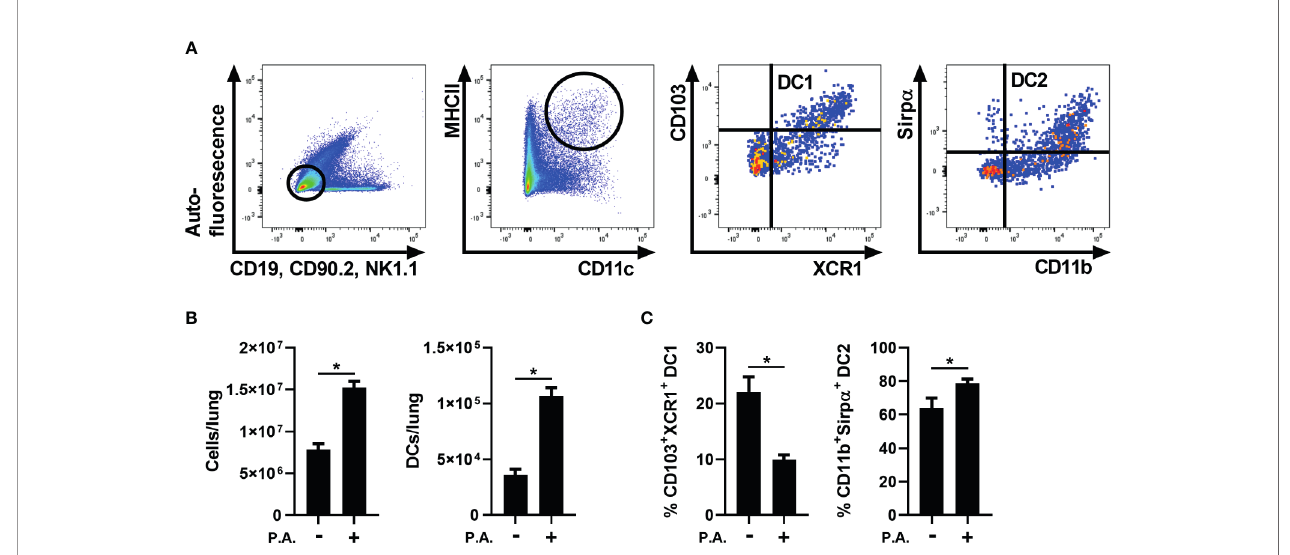
FIGURE 1 | Lung exposure to P. aeruginosa altered the proportions of cDC1s and cDC2s in favor of cDC2s. WT mice were exposed to a single i.n. instillation of 5 x 10 5 CFU of P. aeruginosa (P.A.) and mice were euthanized 18 h later. Lung cDC populations were analyzed by fl ow cytometry. (A) Sequential gating strategy used to identify total cDCs (auto- fl uorescence - , CD19 - , CD90.2 - , NK1.1 - , MHC II Hi and CD11c + ), cDC1 (CD103 + XCR1 + ) and cDC2 (CD11b + Sirp a + ). (B) Number of total lung cells and cDCs (C) Percentage of CD103 + XCR1 + cDC1 and CD11b + Sirp a + cDC2 in lung cDCs. Data are presented as mean ± SEM; n = 8-9 mice per group combined from two separate experiments *p < 0.05 using unpaired